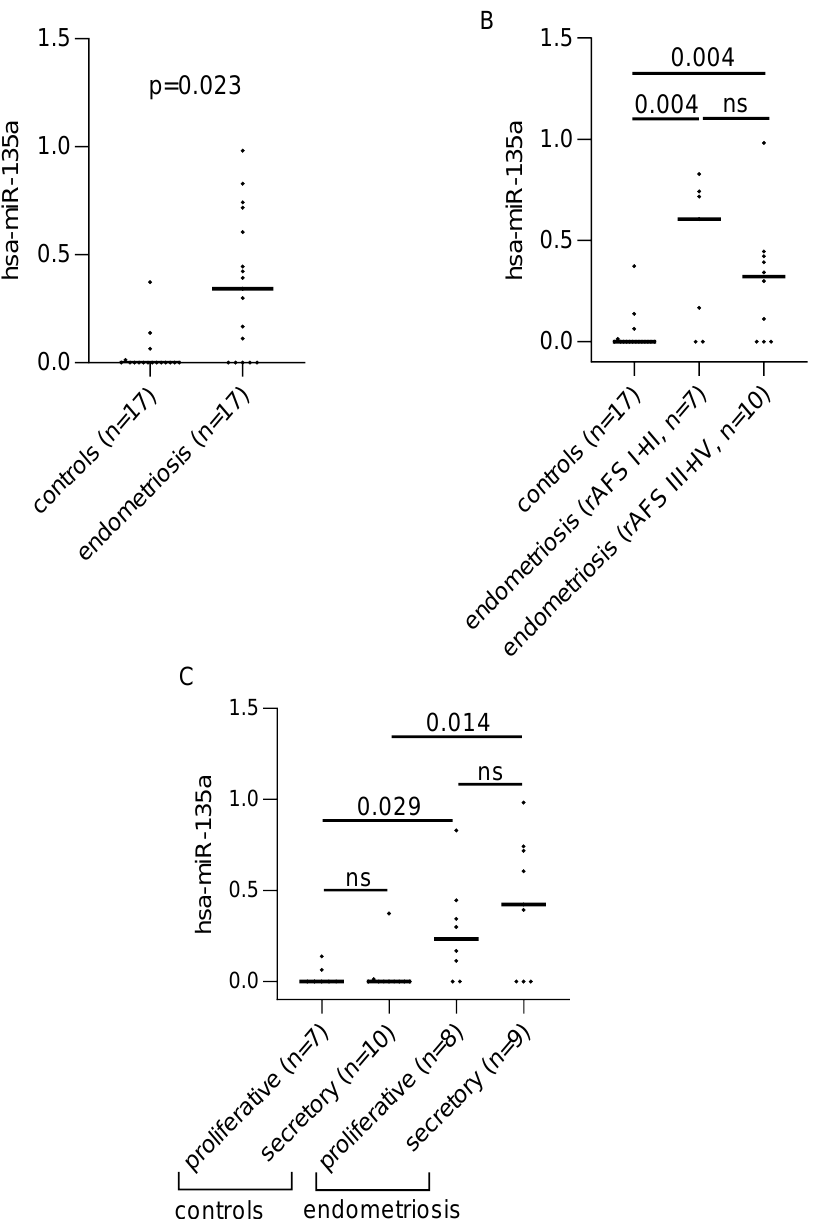
Figure 1. Saliva hsa-miR-135a levels are increased in women with endometriosis. ( A ) Graphical representation of the differences in the levels of expression of hsa-mir-135a in the saliva of women with and without endometriosis. ( B ) The influence of the disease stage on hsa-mir-135a expression levels. ( C ) The effect of menstrual cycle phase on hsa-mir-135a levels in saliva. Significant differences between the groups were detected by a Mann–Whitney U -test followed by correction for multiple testing applying Bonferroni–Holm algorithms. The adjusted p -values of each comparison are shown on the graphs. Abb.: ns = not significant.